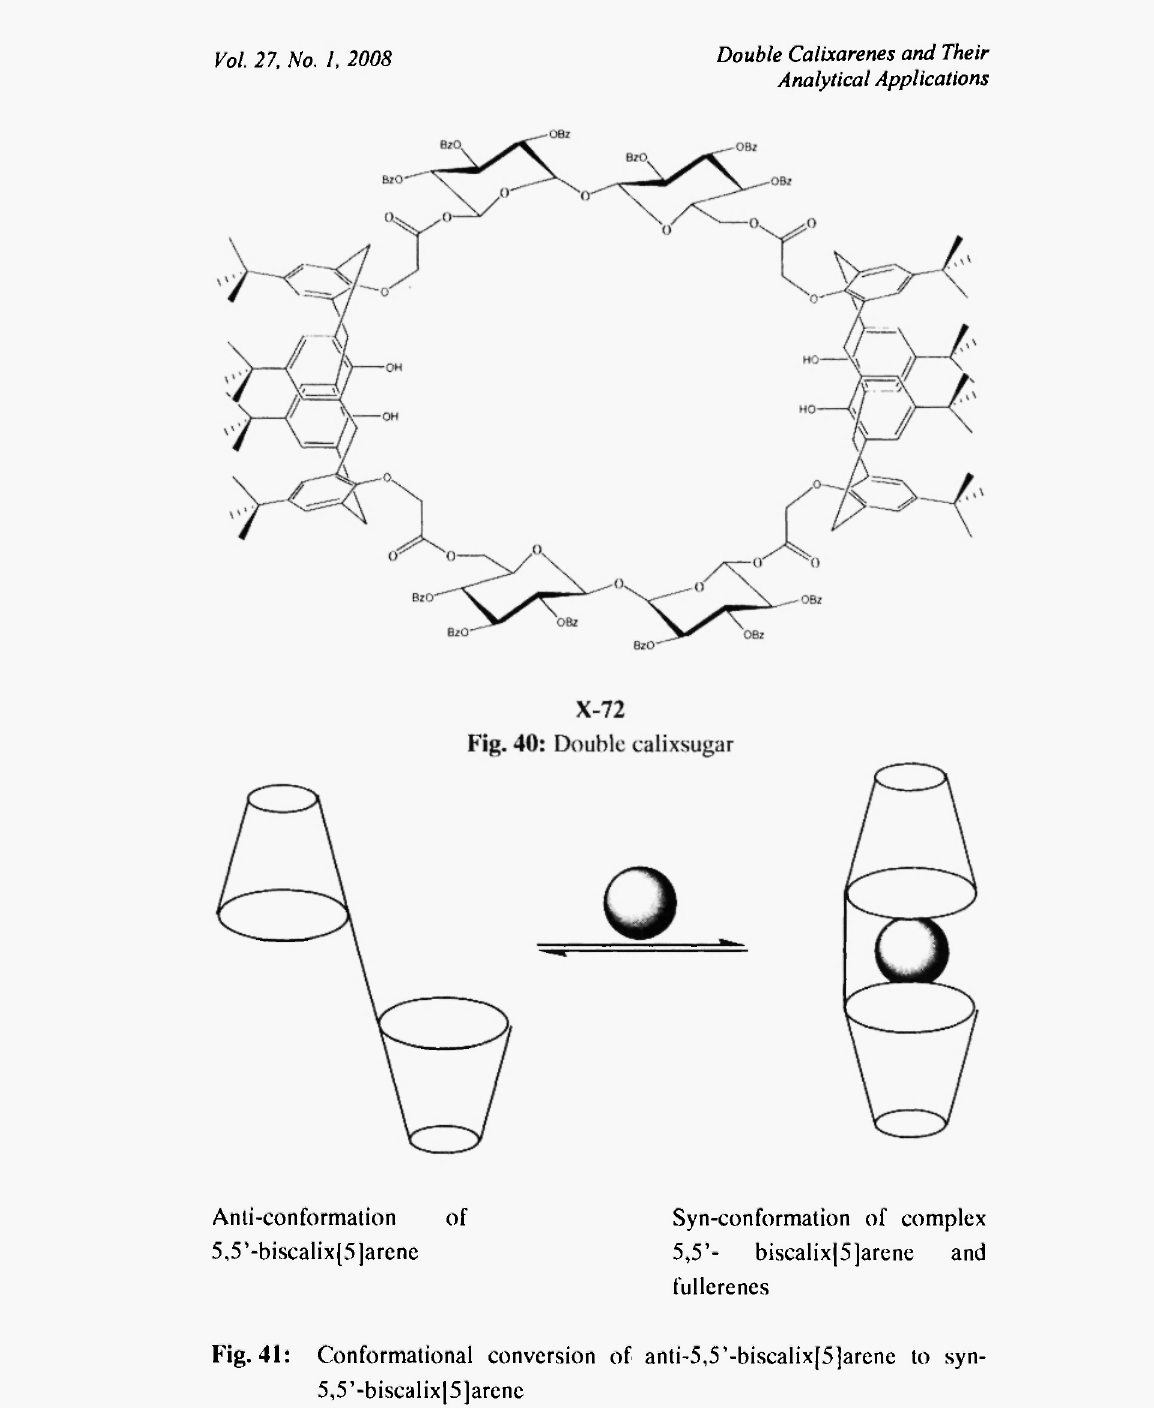
Anii-conformation of Fig. 41: Conformational conversion 5,5'-biscalix|5]arenc